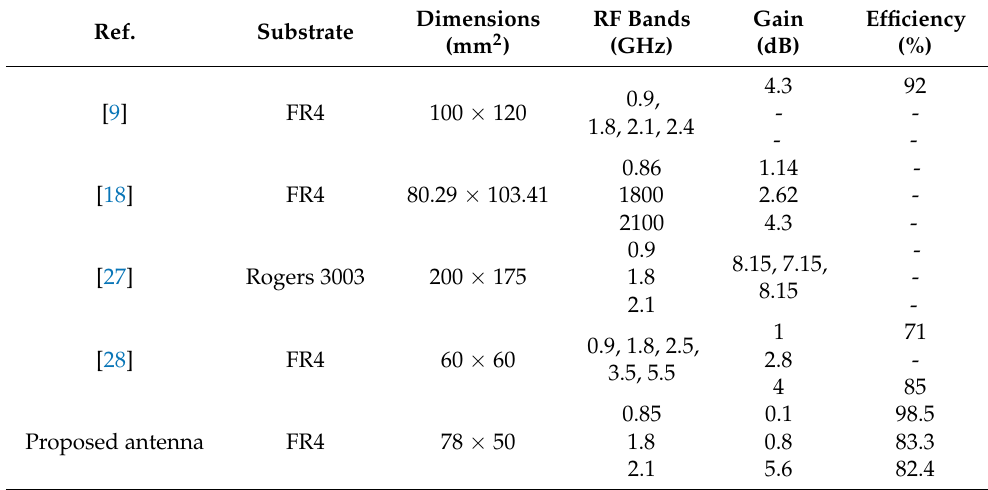
Table 4. Comparative characteristics of the proposed tri-band antenna against related works.